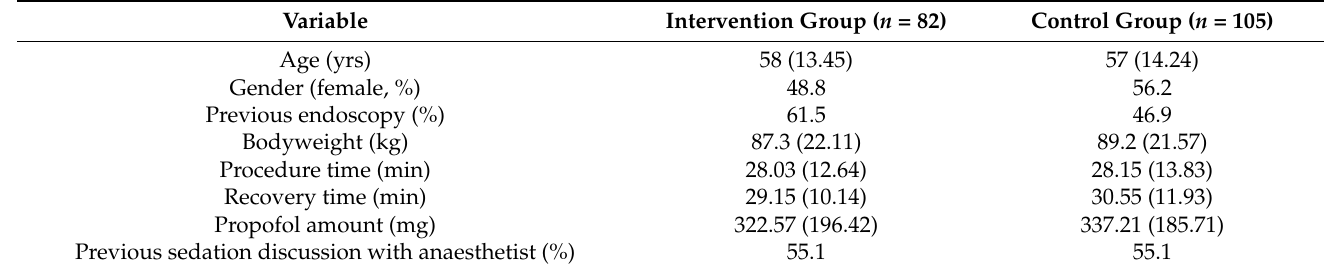
Table 3. Group characteristics.